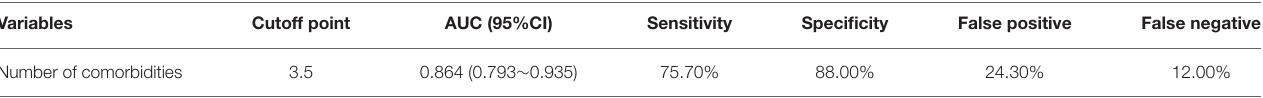
AUC, area under the curve; CI, confidence